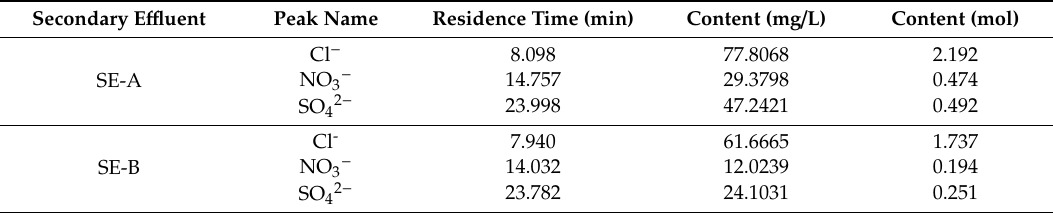
Table 2. The anion ion chromatography content of SE-A and